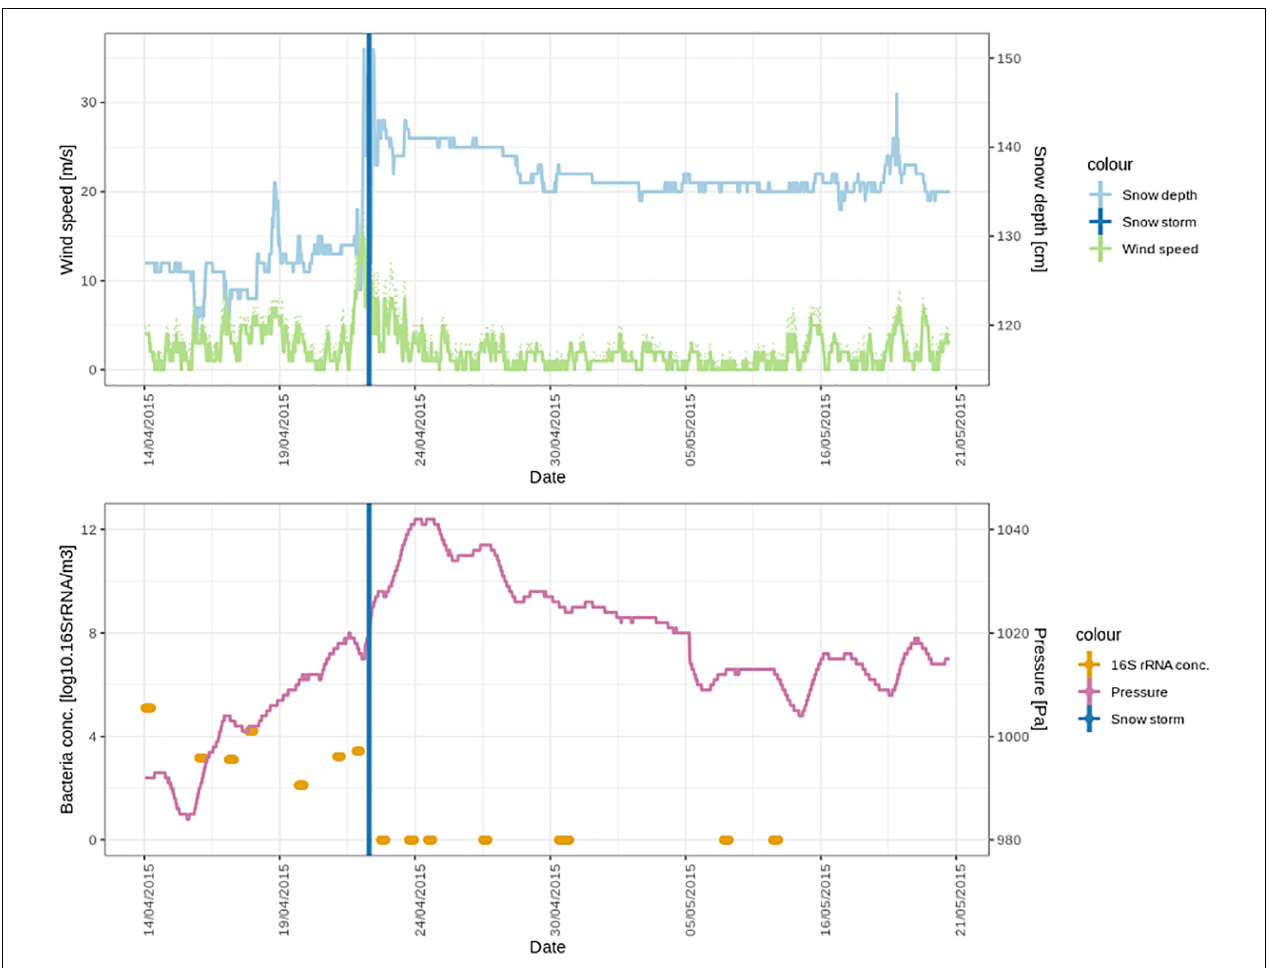
FIGURE 6 | Meteorological conditions and bacterial cell concentrations in April and May 2015, during the period of the snowstorm (22nd of April). In the lower panel, the bacterial cell concentrations are detectable over a week (seven air samples) until the snowstorm. After the snowstorm, no bacterial cells could be detected in the